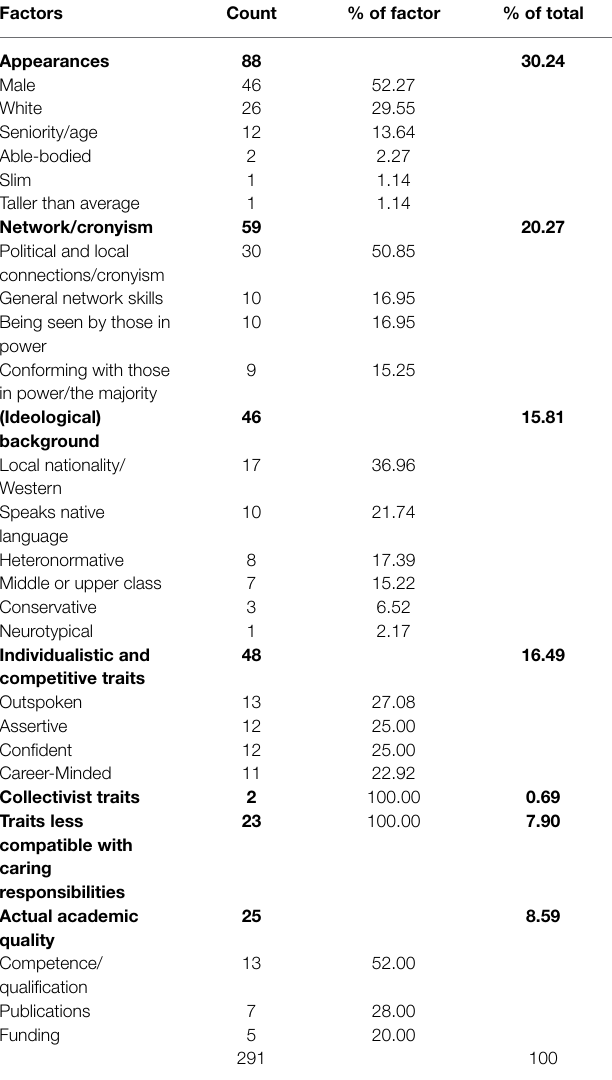
TABLE 6 | Thematic clustering of attributes applying to those who are privileged in the academic environment, as generated by female scholars.